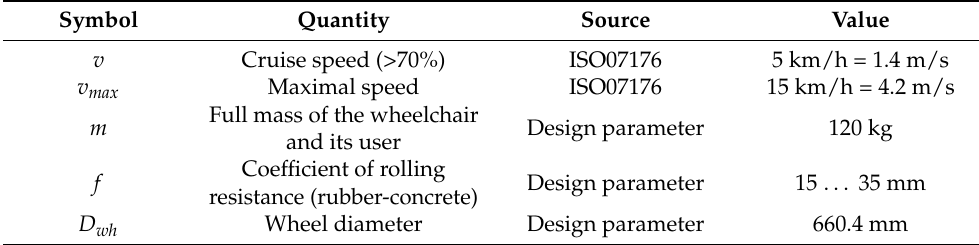
Table 1. Main operation parameters of the